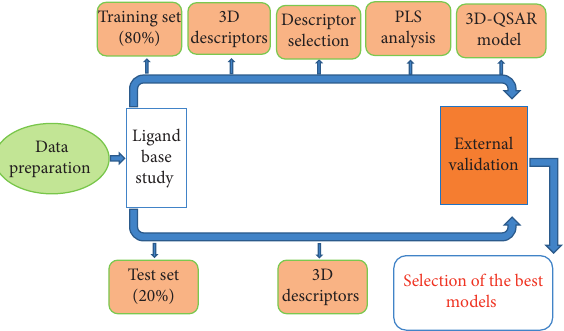
Figure 2: Flowchart for computational drug design. Table 1: Chemical structures and anticancer activities of chalcone